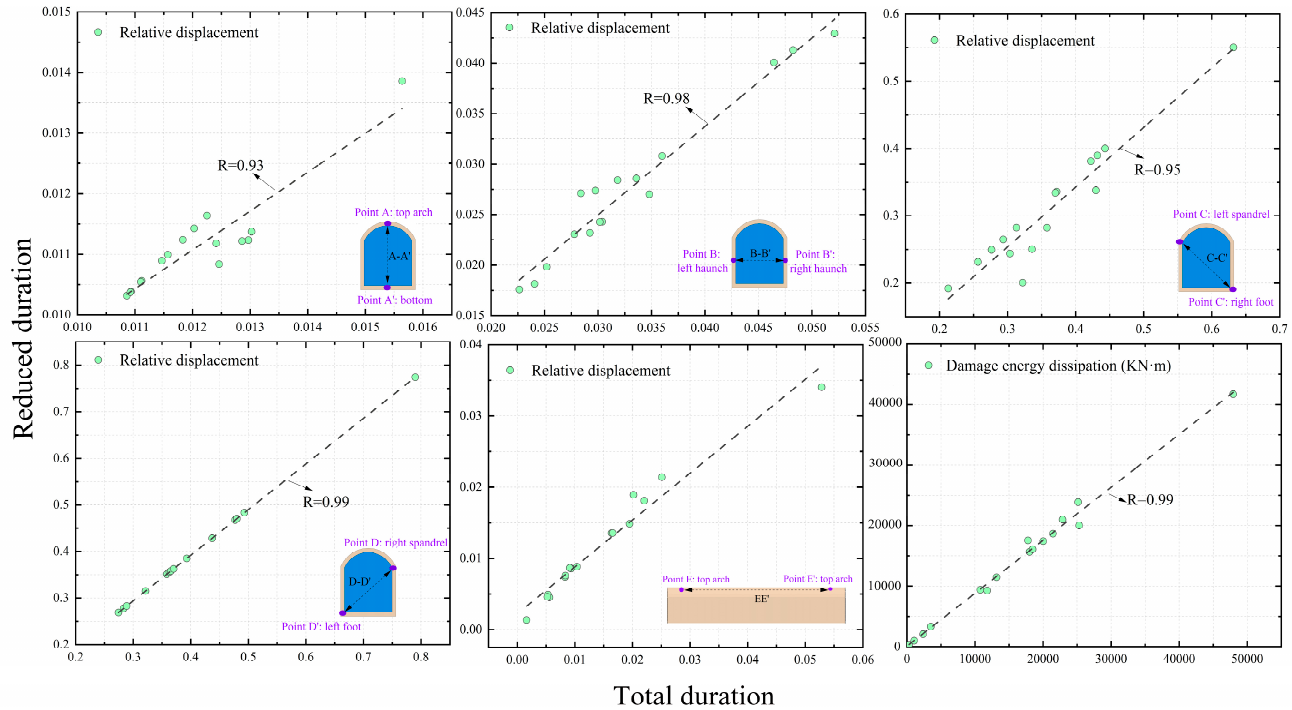
Figure 14. Comparison of the peak value of numerical results for the total duration and the reduced duration of the as-recorded NFGM.